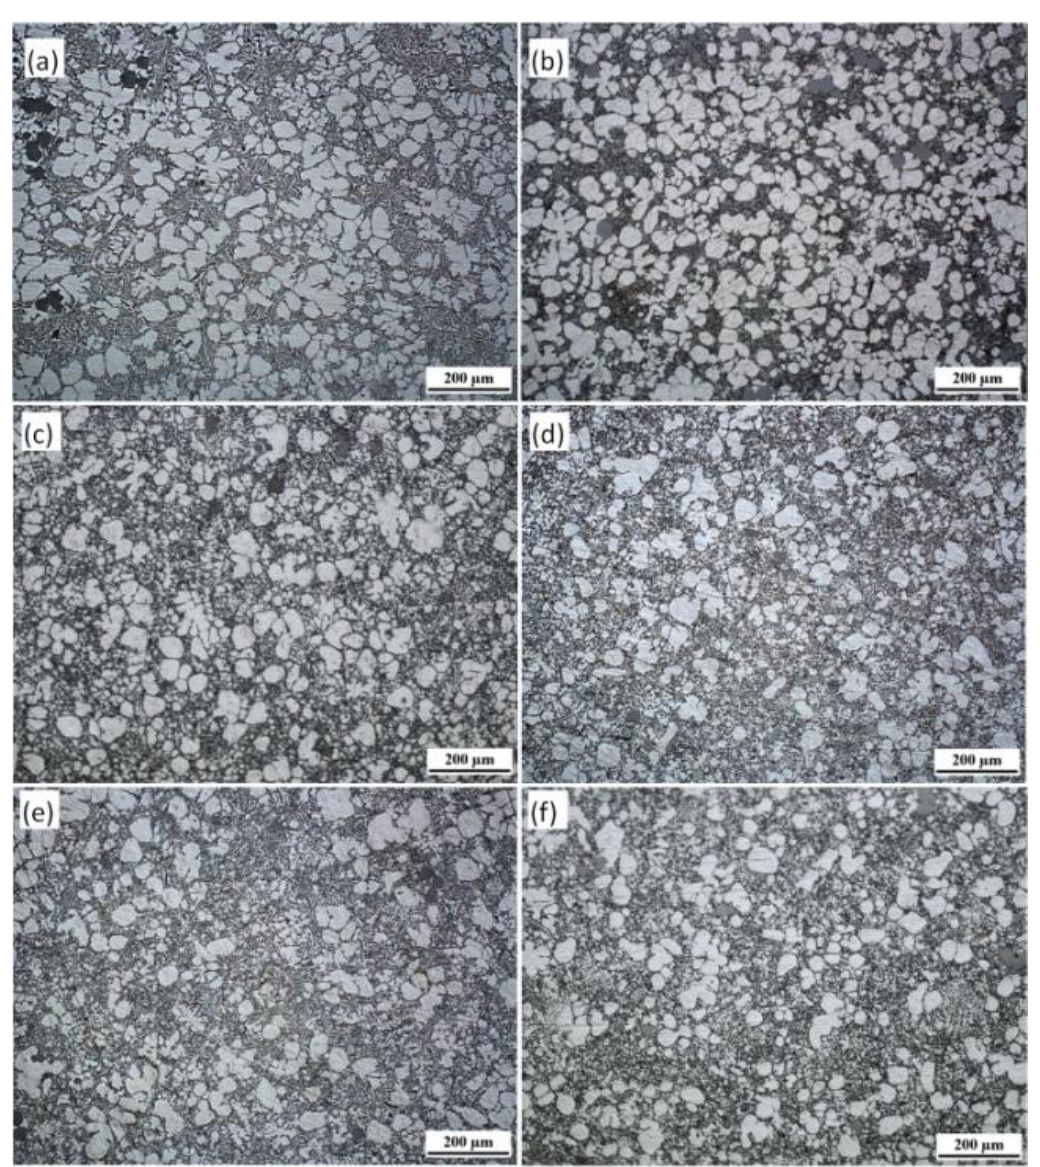
Figure 2. Microstructure distribution of R-HPDC automobile shock absorber part at each point ( a – f